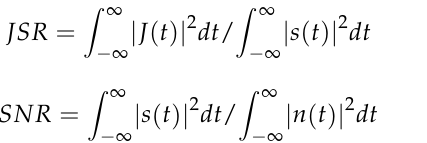
(cid:8) (cid:9) f q 1 ; ( b ) jamming frequency sequences